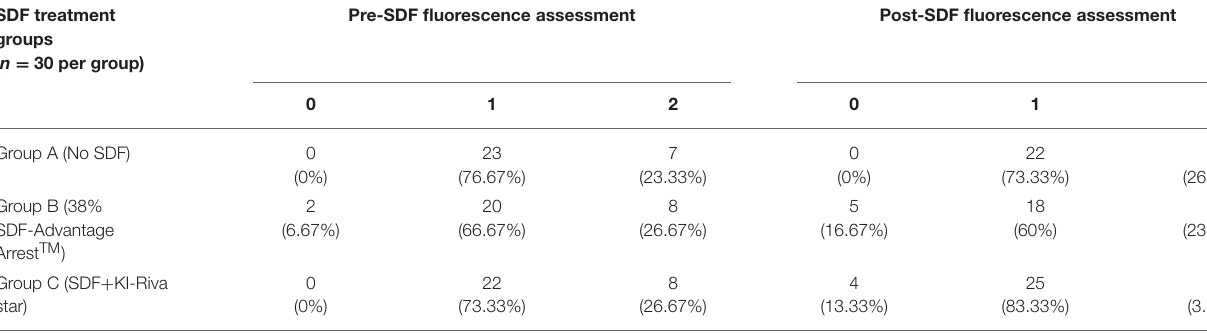
Pre-SDF fluorescence